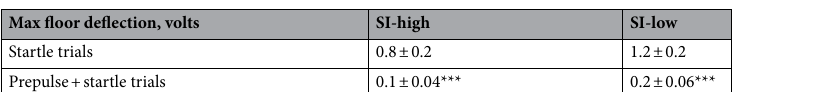
Max floor deflection,